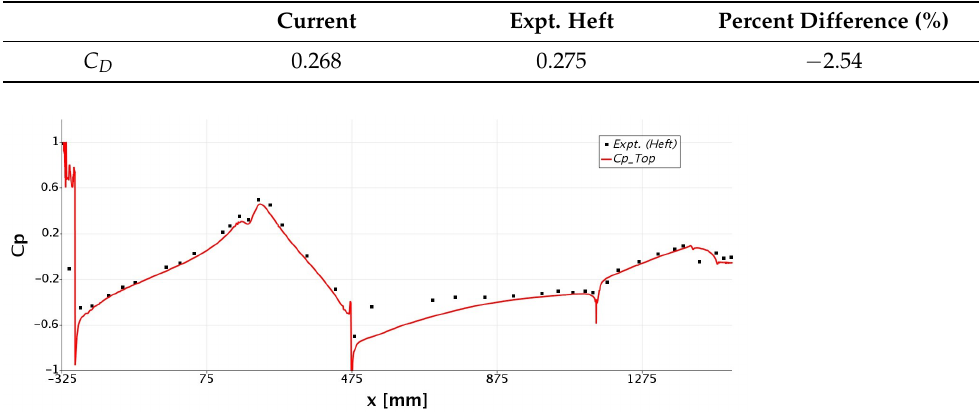
Table 5. Isolated DrivAer Drag Force Coefficient Comparison to Heft [16].